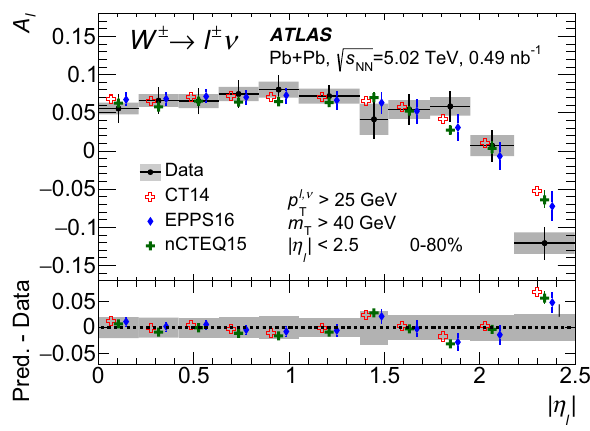
Fig. 11 Combined result for lepton charge asymmetry compared with theory predictions calculated with the CT14 NLO PDF set as well as with EPPS16 and nCTEQ15 nPDF sets. Error bars on the data points show statistical uncertainties, whereas systematic uncertainties are shown as shaded boxes. For the theory predictions, the error bars represent total uncertainties due to PDF uncertainties, scale variations and α S variations. The lower panel shows the differences between the predicted asymmetries and the measured ones with the shaded boxes representing the total experimental uncertainties. The points for theory predictions are shifted horizontally for better visibility